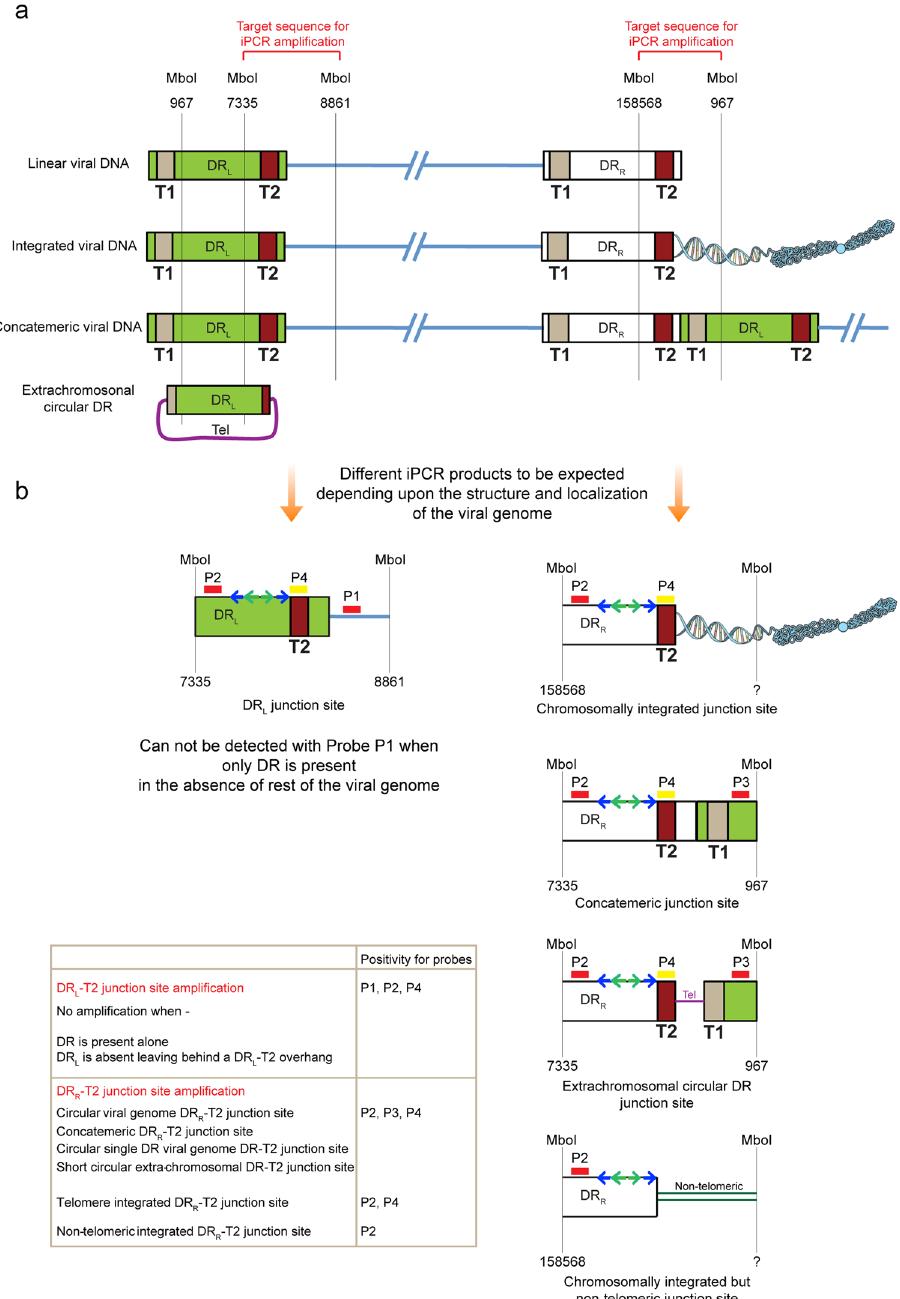
Figure 3. Schematic representation of the inverse PCR experimental set up to amplify DR-T2 junction region. ( a ) Various conformations of HHV-6 genome reported so far are compared on the backdrop of the inverse PCR. MboI is a frequent cutter restriction enzyme. Hence, only the cut sites of our interest are indicated. Nucleotide position of the MboI cut sites (reference genome sequence X83413.1) is indicated. DR L , left direct repeat; DR R , right direct repeat; T1, heterogeneous telomeric repeat sequence; T2, homogeneous telomeric repeat sequence. ( b ) Different combinations of iPCR products expected are described depending upon the structure and integration status of the viral genome. Locations of the 4 hybridisation probes (P1-P4) are marked. First sets of inverse primers are indicated with blue arrows and nested primer pairs are indicated with green arrows. A combination of probes that can detect specific viral structures is indicated within a